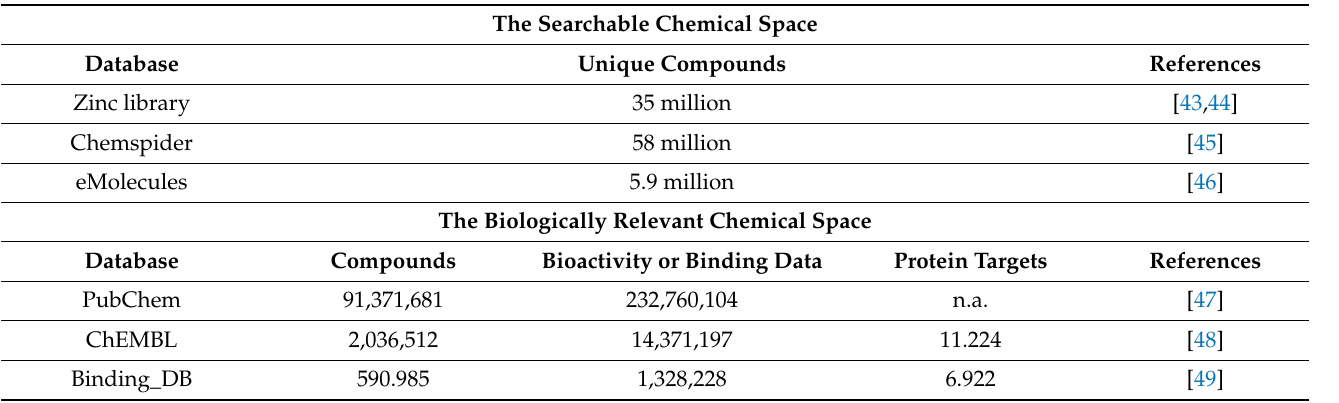
Table 4. Most relevant databases applied frequently in 2D similarity